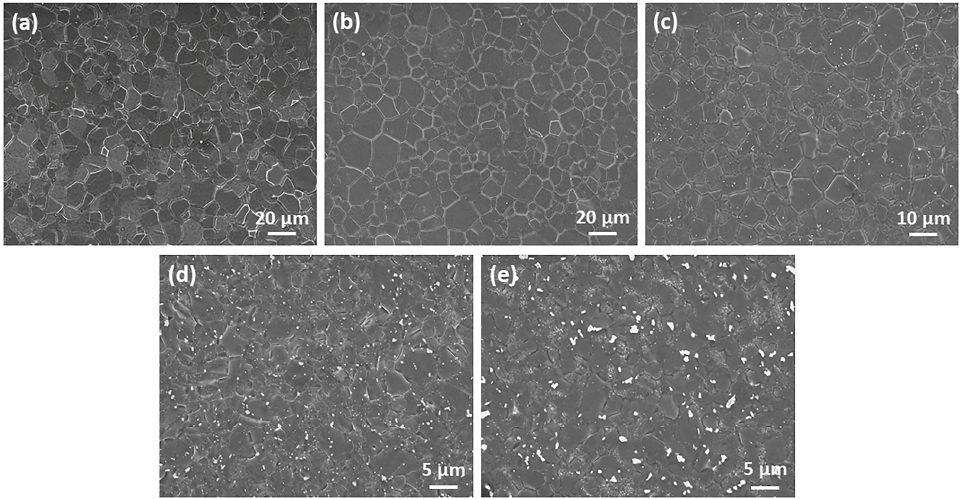
Figure 5. SEM images of as-extruded alloys: ( a ) Alloy1, ( b ) Alloy2, ( c ) Alloy3, ( d ) Alloy4 and ( e ) Alloy5.